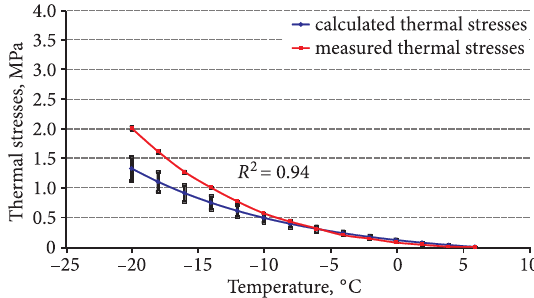
Fig. 7. Calculated and measured thermal stresses in asphalt concrete specimens containing DE 80B SBS modified bitumen